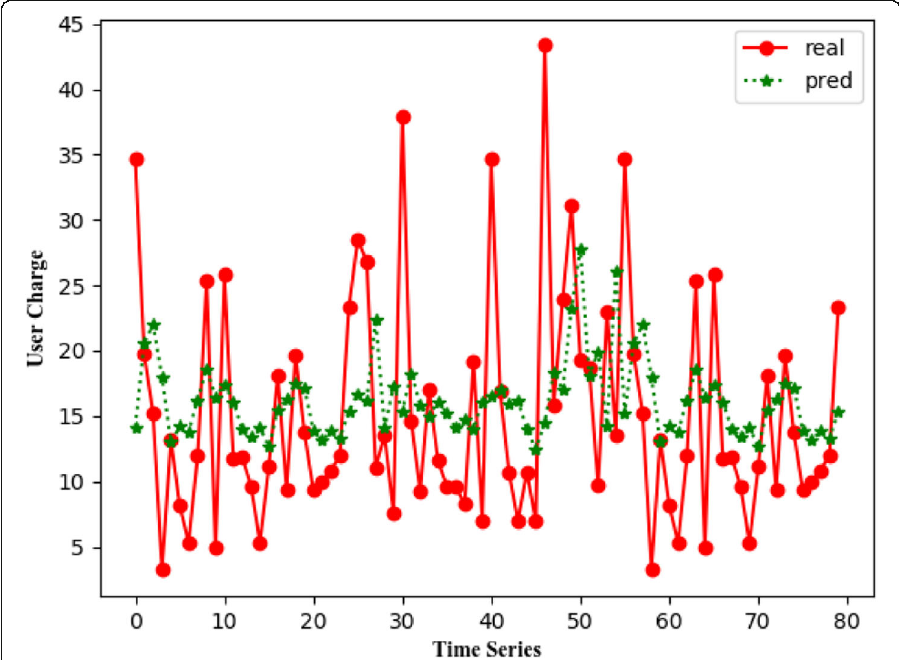
Fig. 6 Irregular charging data prediction results. In this figure, the hybrid artificial intelligence-based prediction model is trained, and the performance is measured